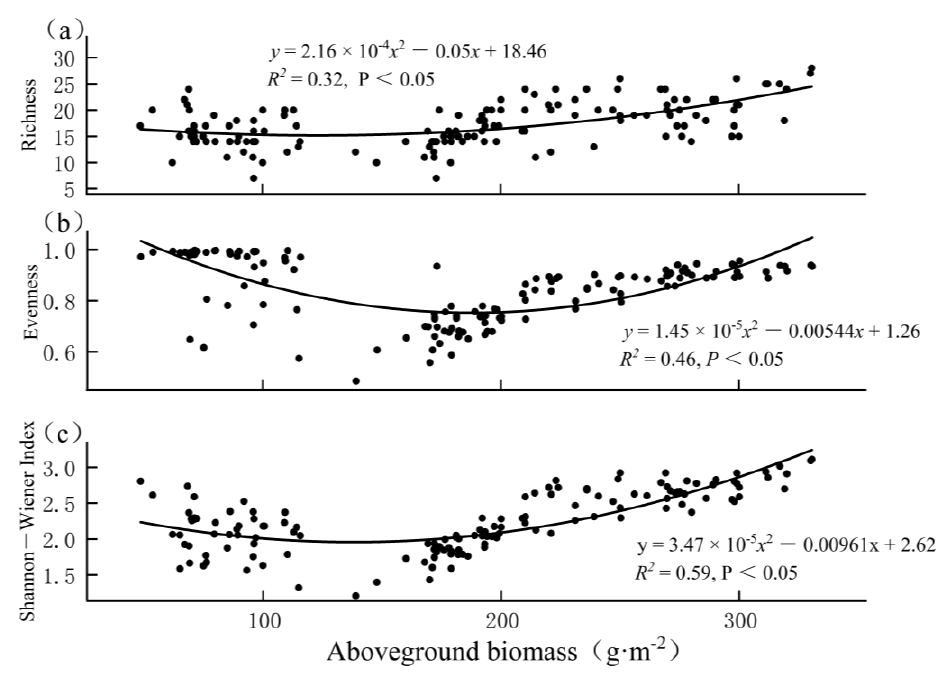
Figure 5. Relationships between aboveground biomass and ( a ) richness, ( b ) evenness, and ( c ) Shannon − Wiener index of alpine meadows across all 143 plots.